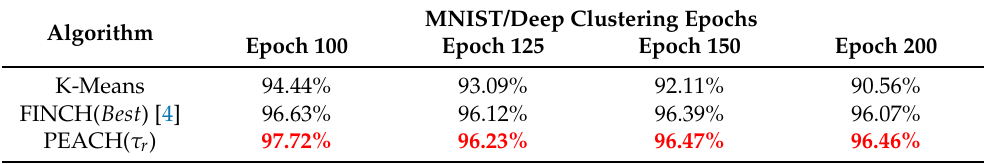
Table 5. Top-1 Accuracy of Linear Classifier of Deep Clustering. We employ LeNet++ for deep clustering of MNIST, and we report the top-1 accuracy of a converged linear classifier after feature extraction. PEACH( τ r ) achieves higher accuracy than K-Means and FINCH at each of the deep clustering epochs examined.